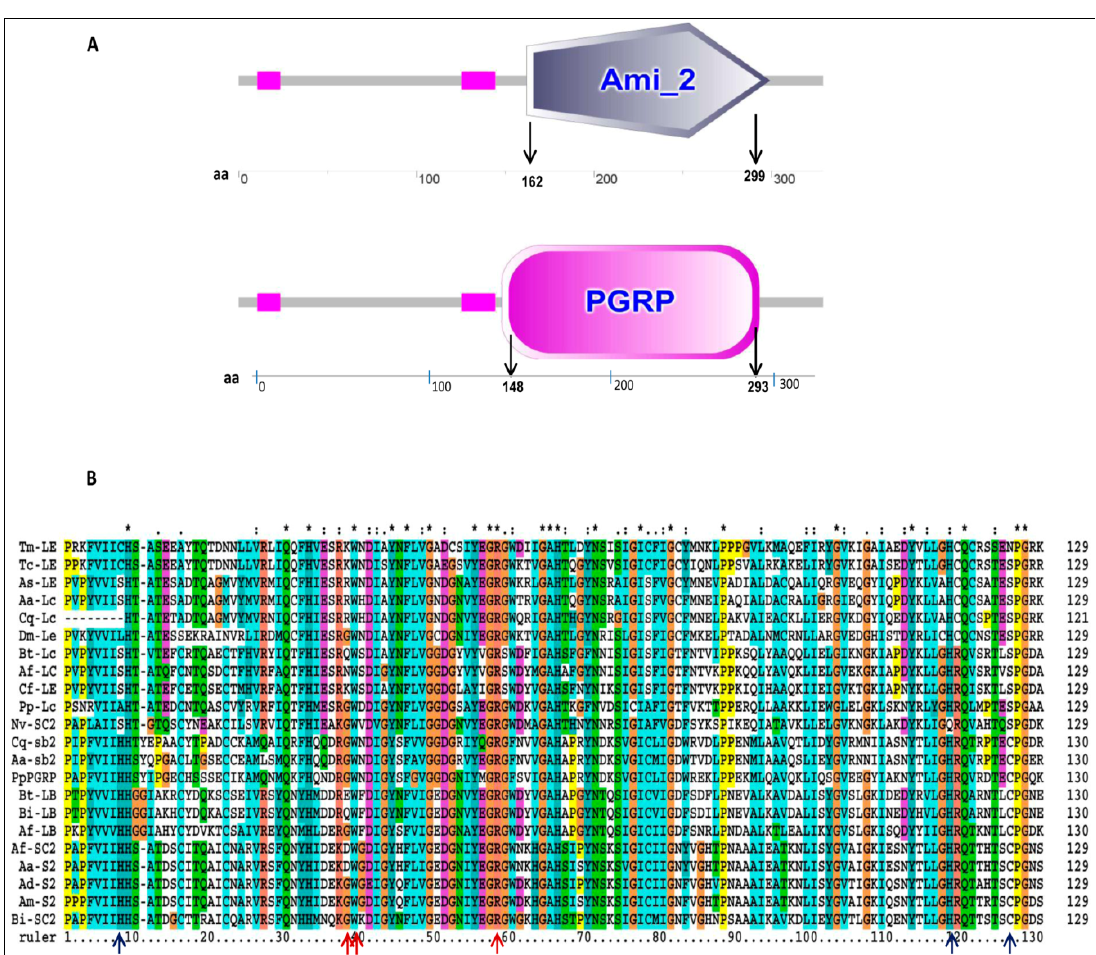
Figure 2. Characterization and alignment of amino acid sequences of TmPGRP-LE homologues. ( A ) Domain architecture predicted using SMART analysis tool. Ami-2 and PGRP stand for predicted amidase-2 and PGRP domains, respectively; and ( B ) Multiple sequence alignment of amidase/PGRP domains of PGRP family members in representative insects. The sequences have been compiled from NCBI database and have been represented by accession numbers (Figure 3 for details). Catalytic residues for amidase activity and specific PGN recognition residues are indicated by blue and red arrows, respectively. Residues shared are indicated with the following symbols: “ * ” (denotes identical residues in all sequences); “ : ” (conserved substitutions according to similar properties of amino acids); “ . ” (indicates semi-conserved amino acid substitutions). Dashes indicate gaps used to maximize the